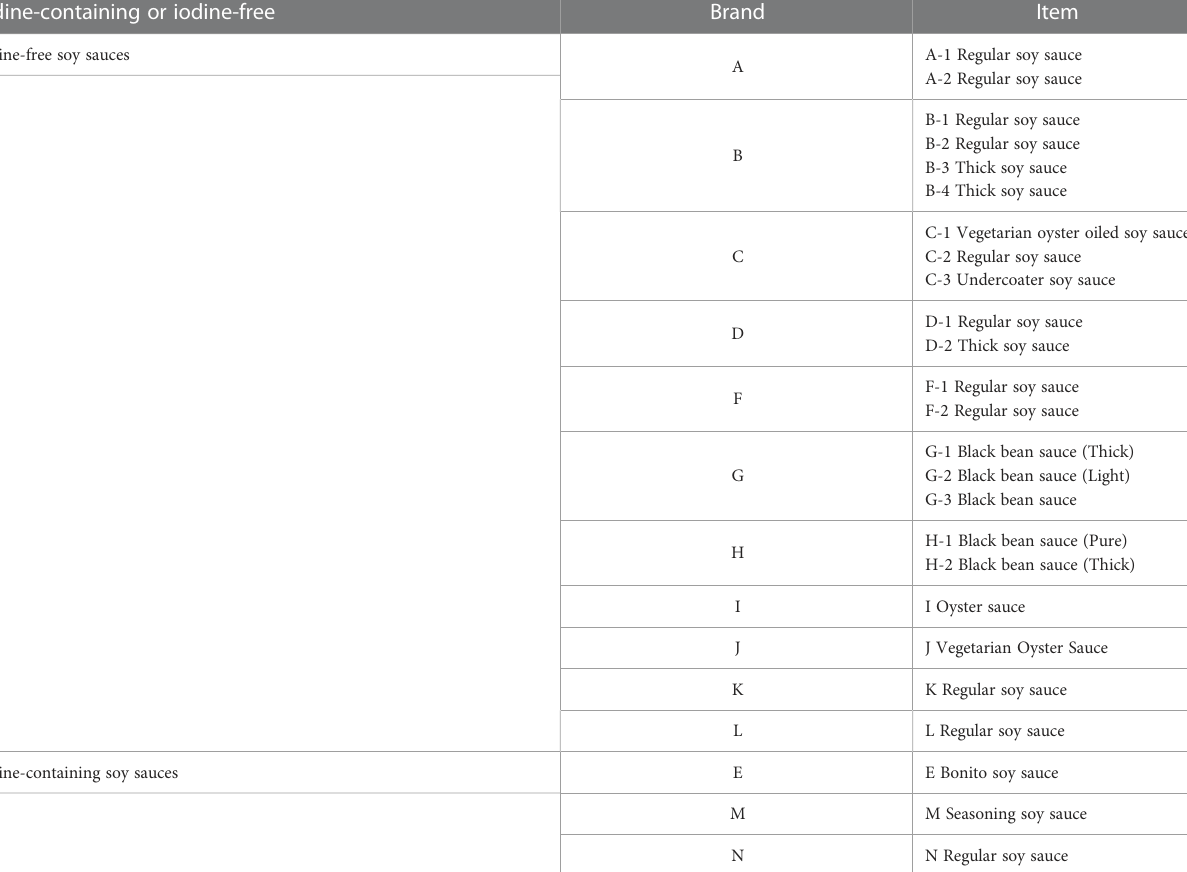
TABLE 1 Iodine-containing soy sauces and iodine-free soy sauces. Iodine-containing or iodine-free Brand Item Iodine-free soy